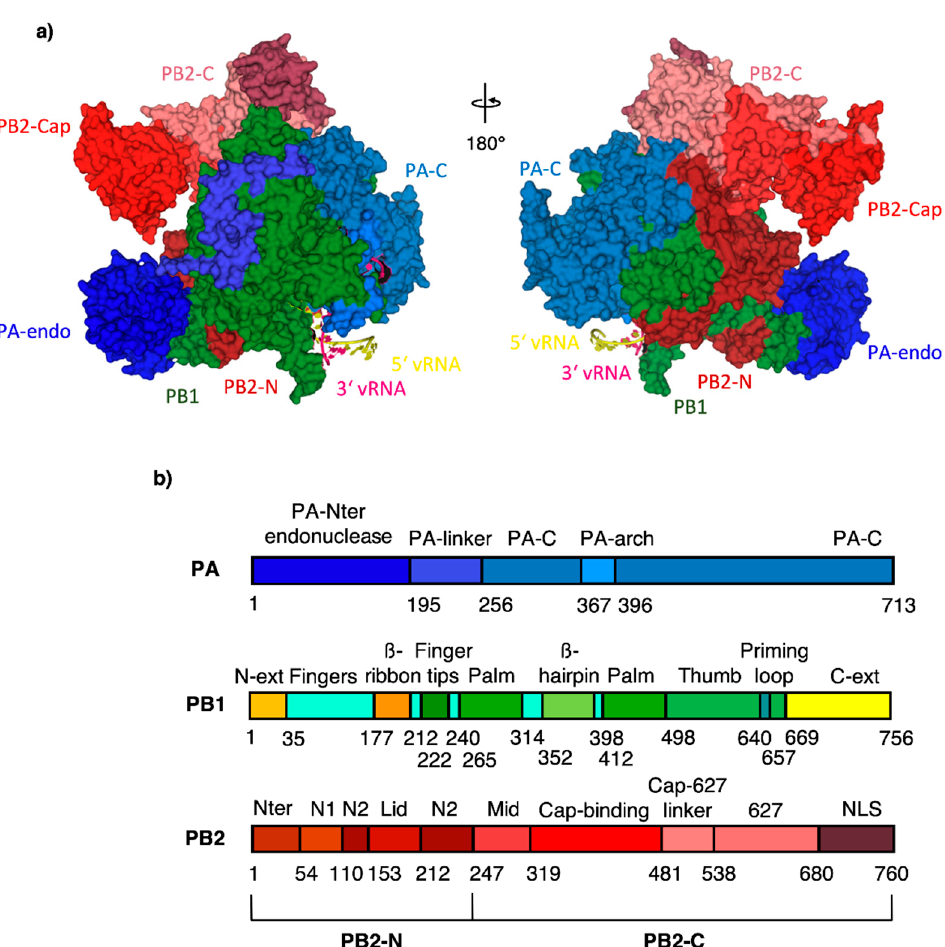
Figure 1. ( a ) RdRp subunit domain structure with subdomain names; color-coding according to the domain structure viewed in ( b ) except PB1 and PB2-N, which are uniformly in green and dark red for clarity. PDB code 4WSB [5].